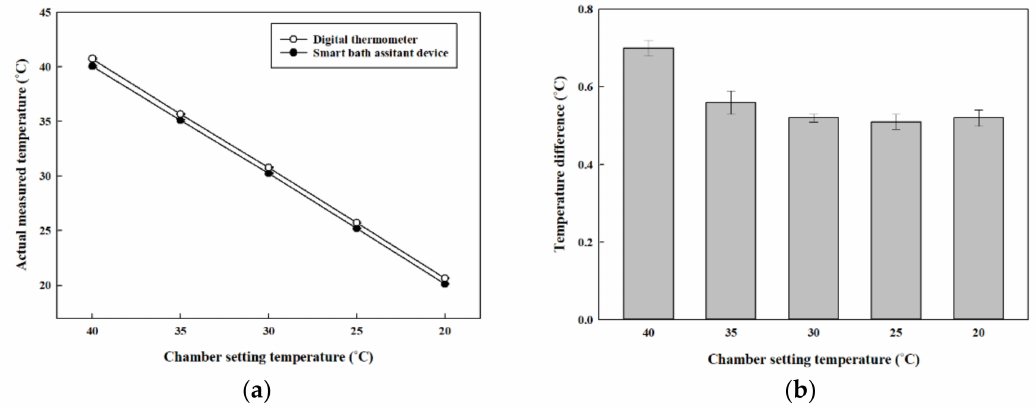
Figure 8. Results of the proposed smart bath assistive device in temperature measurement and wireless data communication performance test: (a) temperature variation; (b) temperature di ff